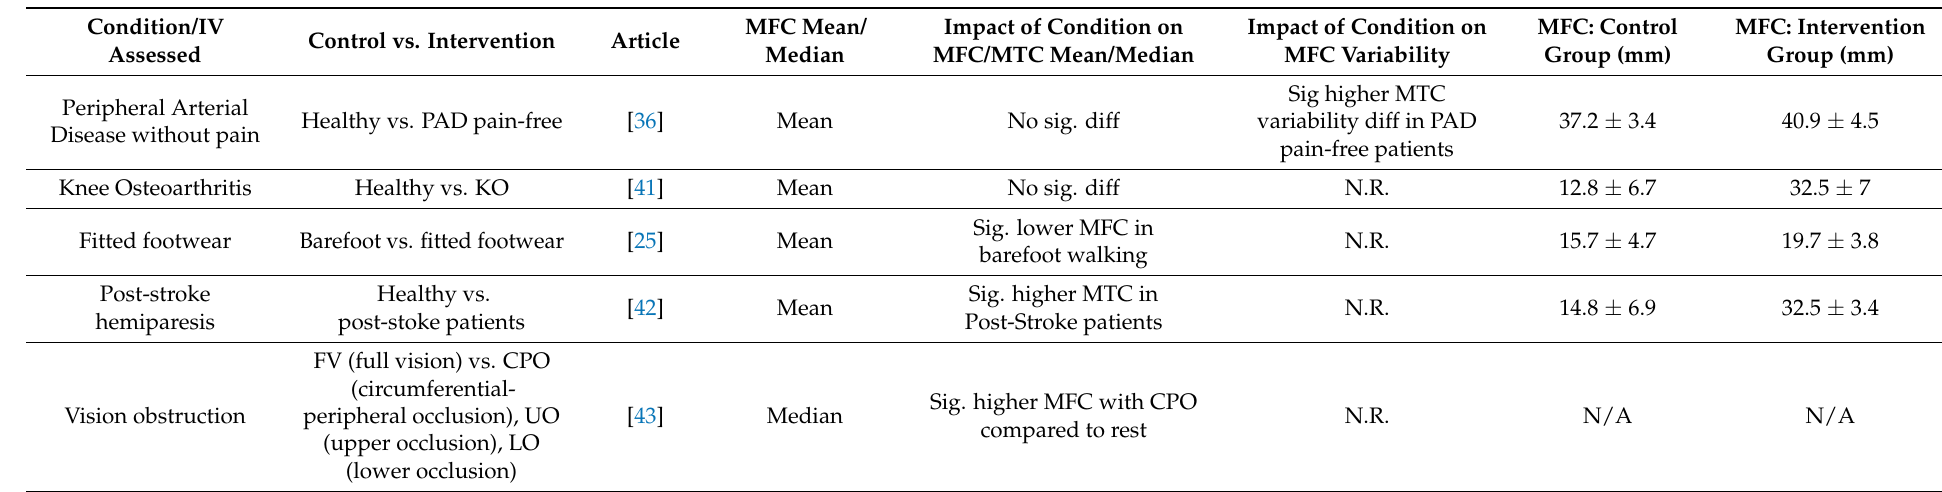
Table 3. Summary of findings in included papers for conditions that increase mean or median MFC relative to